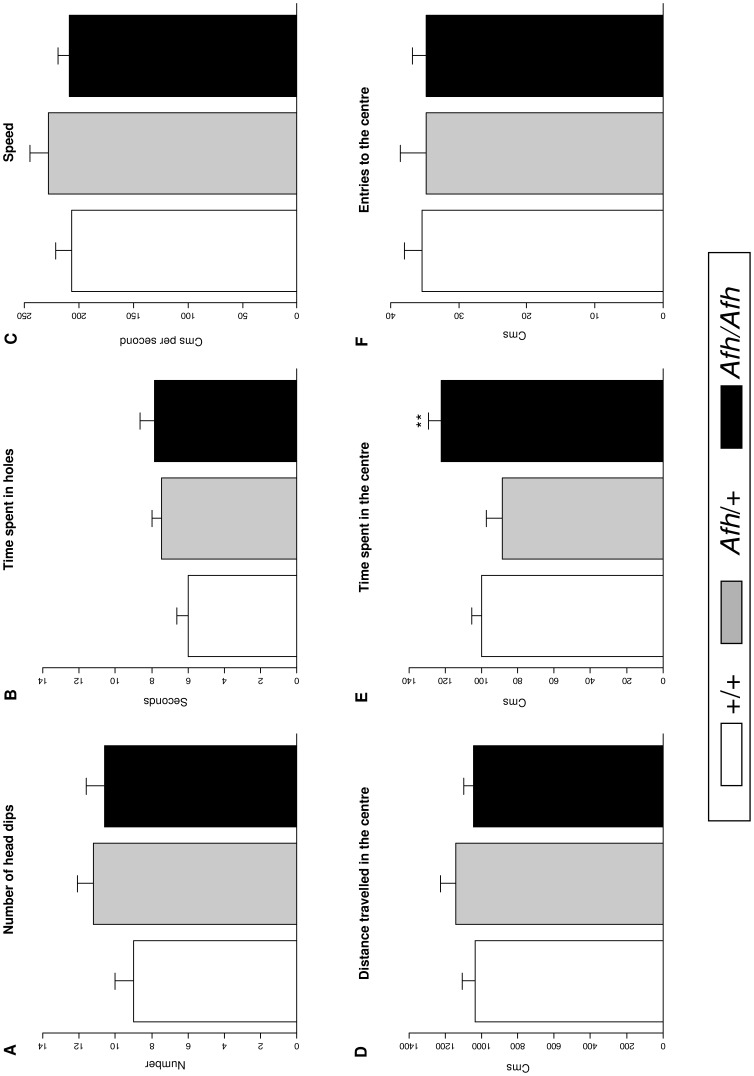
The effect of after hours genotype on exploratory and anxiety-like behaviour in the holeboard.Results from the holeboard test indicate no difference in exploratory behaviours (A–B) or overall activity (C–D). Afh/Afh mice spent more time in the centre (E) but did not differ in their number of entries (F). (Data shown is mean ± SEM). **, P<0.01 effects of genotype in posthoc t-tests (Afh/Afh vs. Afh/+ and +/+).